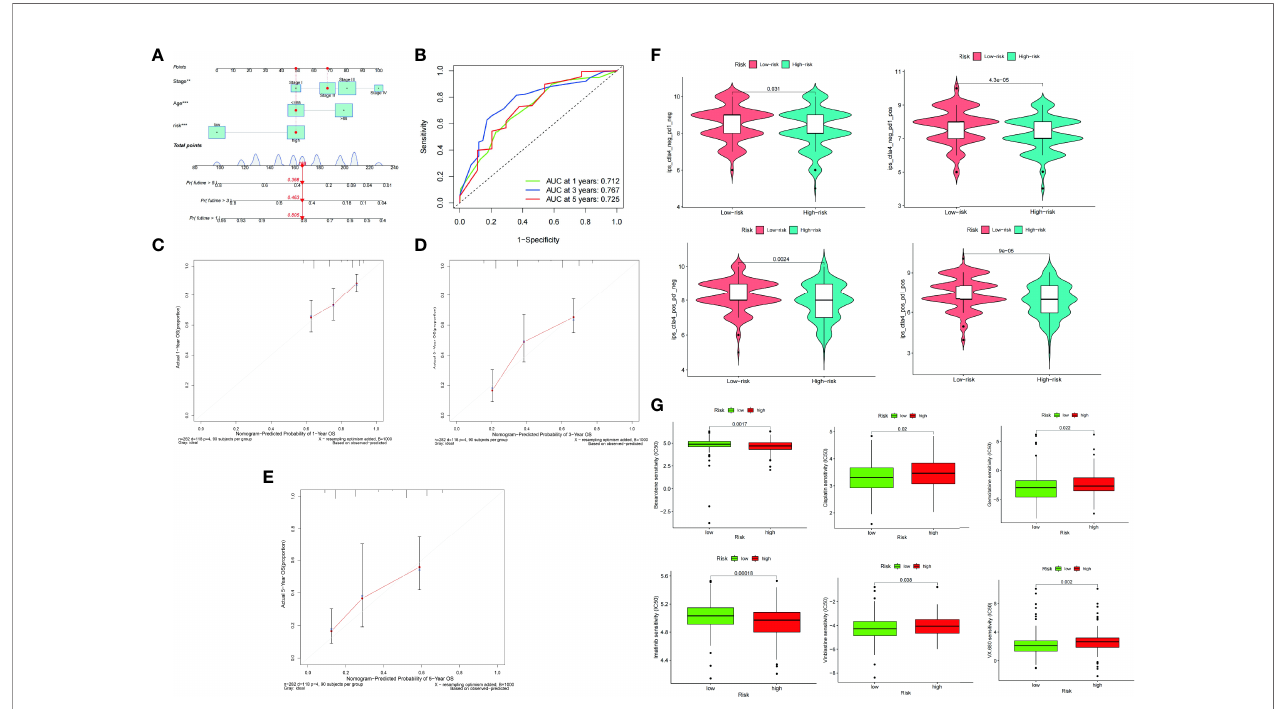
FIGURE 8 | A nomogram was constructed on the basis of age, pathological stage, and risk score (A) . ROC curve of the nomogram at 1, 3, and 5 years (B) . Calibration plots of overall survival (OS) at 1 (C) , 3 (D) , and 5 years (E) . Differences in PD-1 and CTLA-4 therapy sensitivity between the low- and high-risk populations (F) . Differences in chemotherapy sensitivity between the low- and high-risk populations (G)